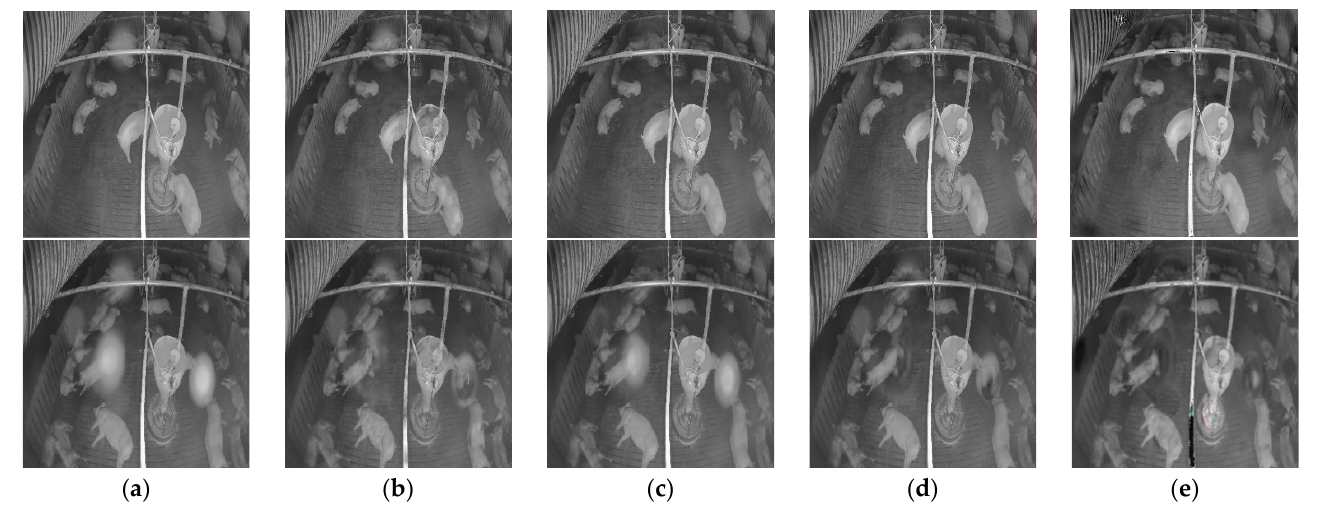
Figure 15. Comparisons of each model’s denoising performance on different level real-noise images.